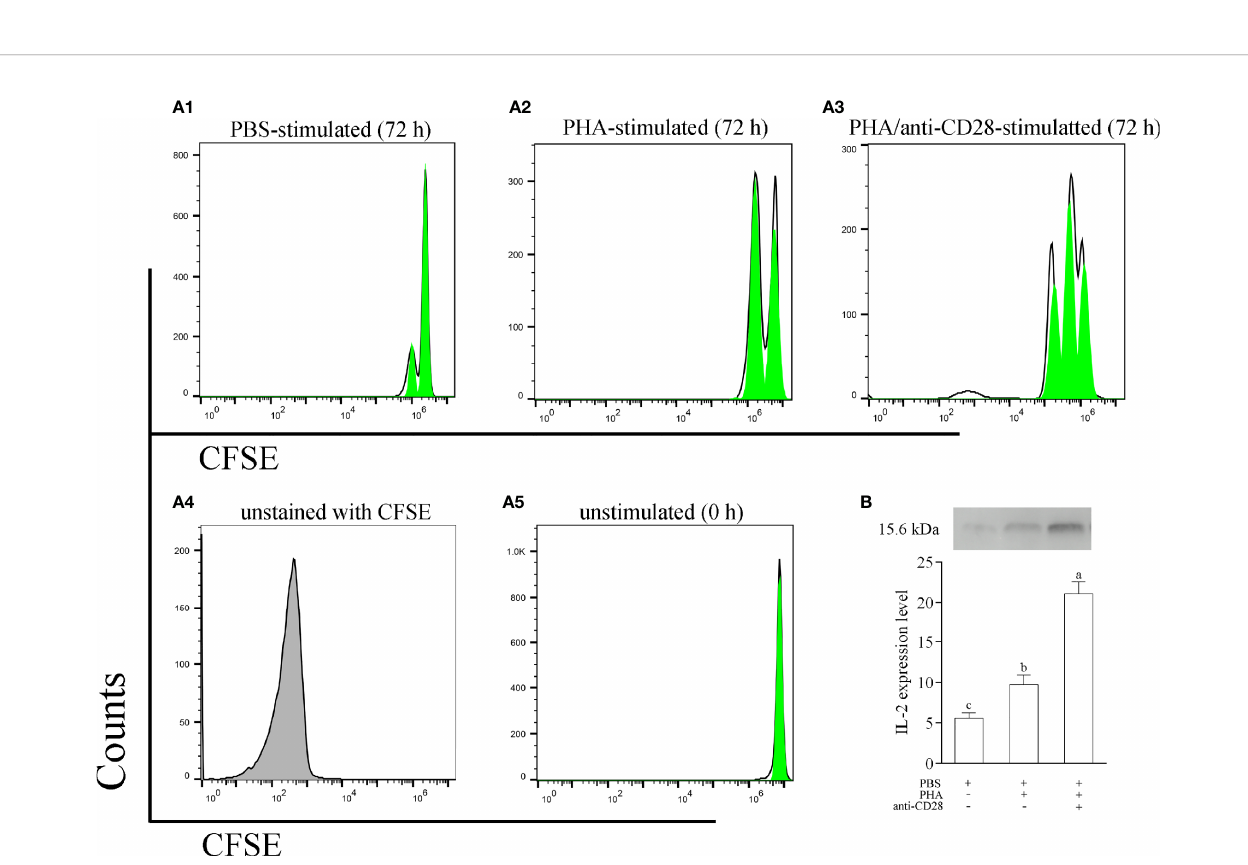
FIGURE 7 | (A) The proliferation of leukocytes was monitored using CFSE labeling. CFSE-labeled PBLs (5 × 10 6 cell/well) were treated with L-15 medium in the presence of PBS, PHA, or PHA+anti-CD28 were analyzed at 72 h of culture; data are representative of nine individuals. (B) The level of IL-2 in the culture medium at 72 h was measured by Western blot. The PBLs were stimulated with PBS, PHA, and PHA/anti-CD28, respectively. The experiment was repeated independently three times. Letters on the bar represent the statistically signi fi cant difference, p <